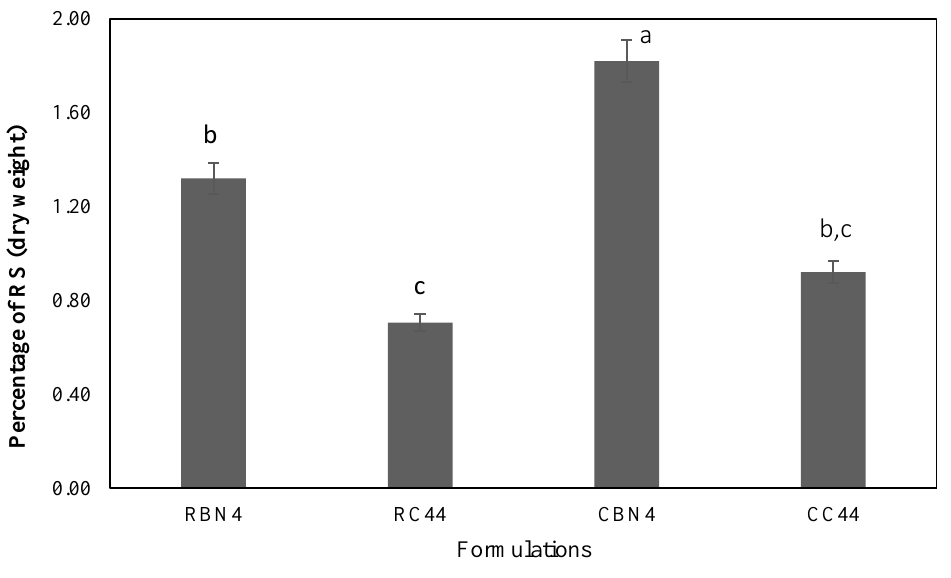
Figure 4. Percentage of resistant starch in four formulations of a dairy dessert (different letters indicating significant difference, p < 0.05 by Tukey test).